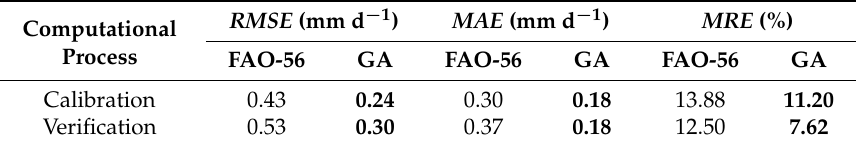
Table 5. Root mean square error ( RMSE ), mean absolute error ( MAE ) and mean relative error ( MRE ) of estimated winter wheat evapotranspiration under full irrigation using crop coefficients that were optimized by the genetic algorithm (GA) and recommended by the FAO-56.